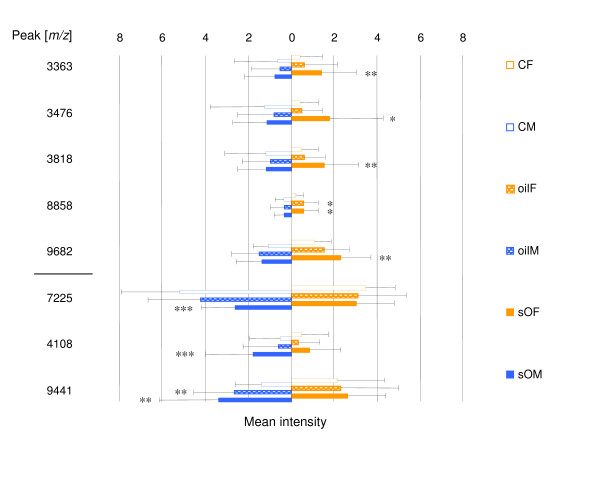
Histogram of sex dependent expression changes (intensities as arbitrary units) obtained for digestive gland of M. edulis upon 21d exposure to 0.5 mg/L crude oil (oil) and 0.5 mg/L crude oil spiked with a mixture of APs and PAHs (0.1 mg/L; sO); CF = control females, CM = control males, sOF = spiked oil females, sOM = spiked oil males, oilF = oil females, oilM = oil females; males are in blue and females in orange; the upper five represent female-specific and lower three male-specific peaks. Significantly different at 0.05 ≥ p ≥ 0.01, **, at 0.01 ≥ p ≥ 0.001, ***, at p < 0.001.